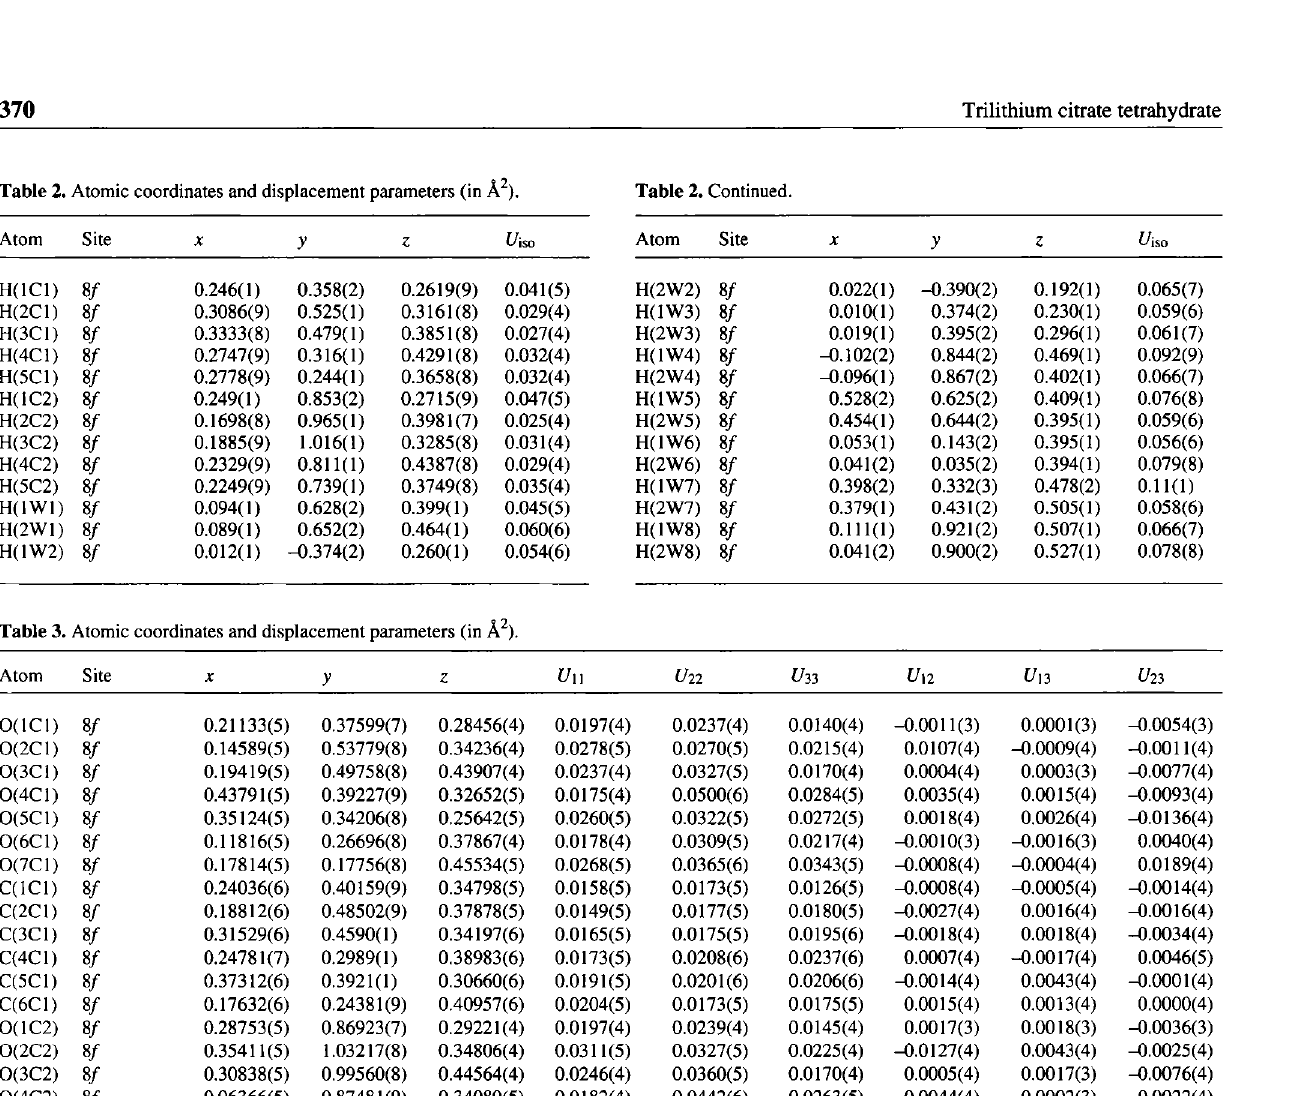
Table 3. Atomic coordinates and displacement parameters (in Ä 2